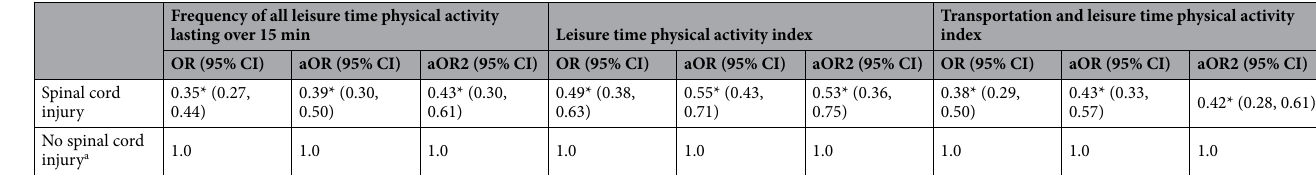
Table 3. Odds ratios for association between spinal cord injury and physical activity (probability-weighted). CI confidence interval, OR odds ratio. a Reference category. *Statistically significant p <